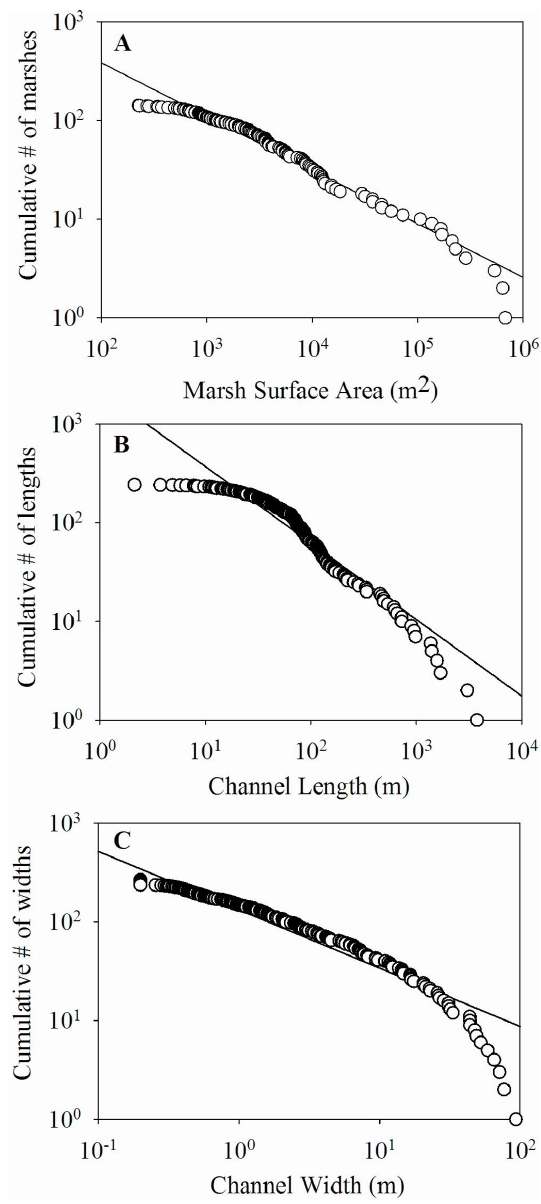
Fig. 3. Geomorphic data for the tidal freshwater portion of the Patuxent River. (A) Cumulative number of marsh areas less than or equal to indicated value ( N = 4712 . 3 A − 0 . 54 , n = 142, R 2 = 0 . 96). (B) Cumulative number of channel lengths less than or equal to in- dicated size ( N = 2224 . 1 L − 0 . 78 , n = 242, R 2 = 0 . 90). (C) Cumu- lative number of inlet channel widths less than or equal to indicated value ( N = 133 . 23 W − 0 . 59 , n = 267, R 2 = 0 . 92). Standard error is less than size of data